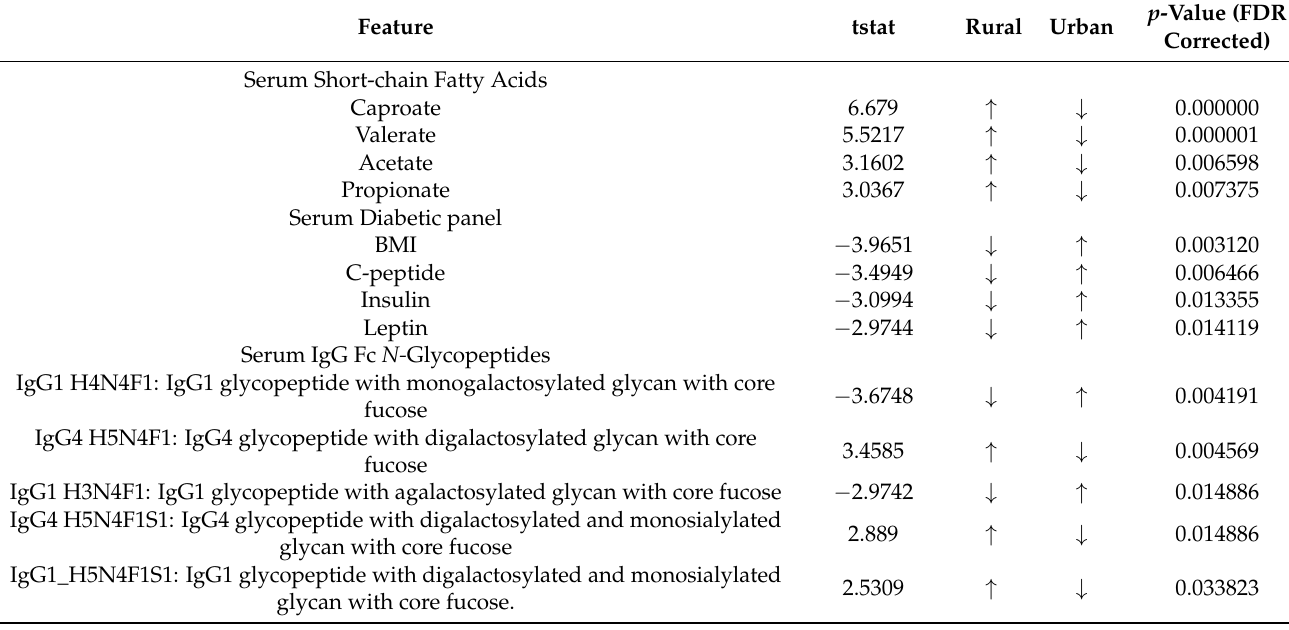
Table 2. Features which show significant differential responses between rural and urban cohorts are shown using two- tailed Student’s t-test. An FDR corrected p -value is shown in the last column. Arrows ( ↑ / ↓ ) represent features that were increased/decreased in the corresponding